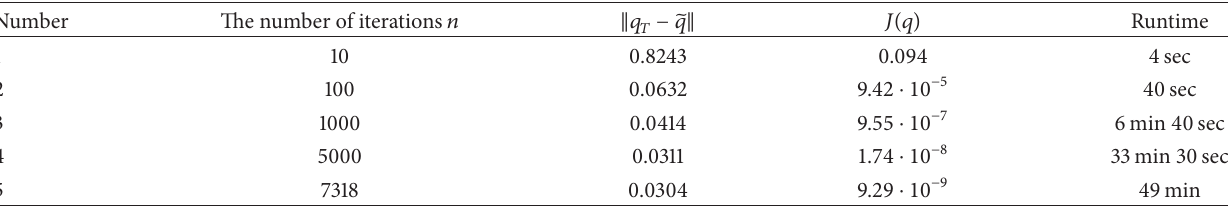
Table 1: Calculation results in the case of no noise 𝜀 = 0 .